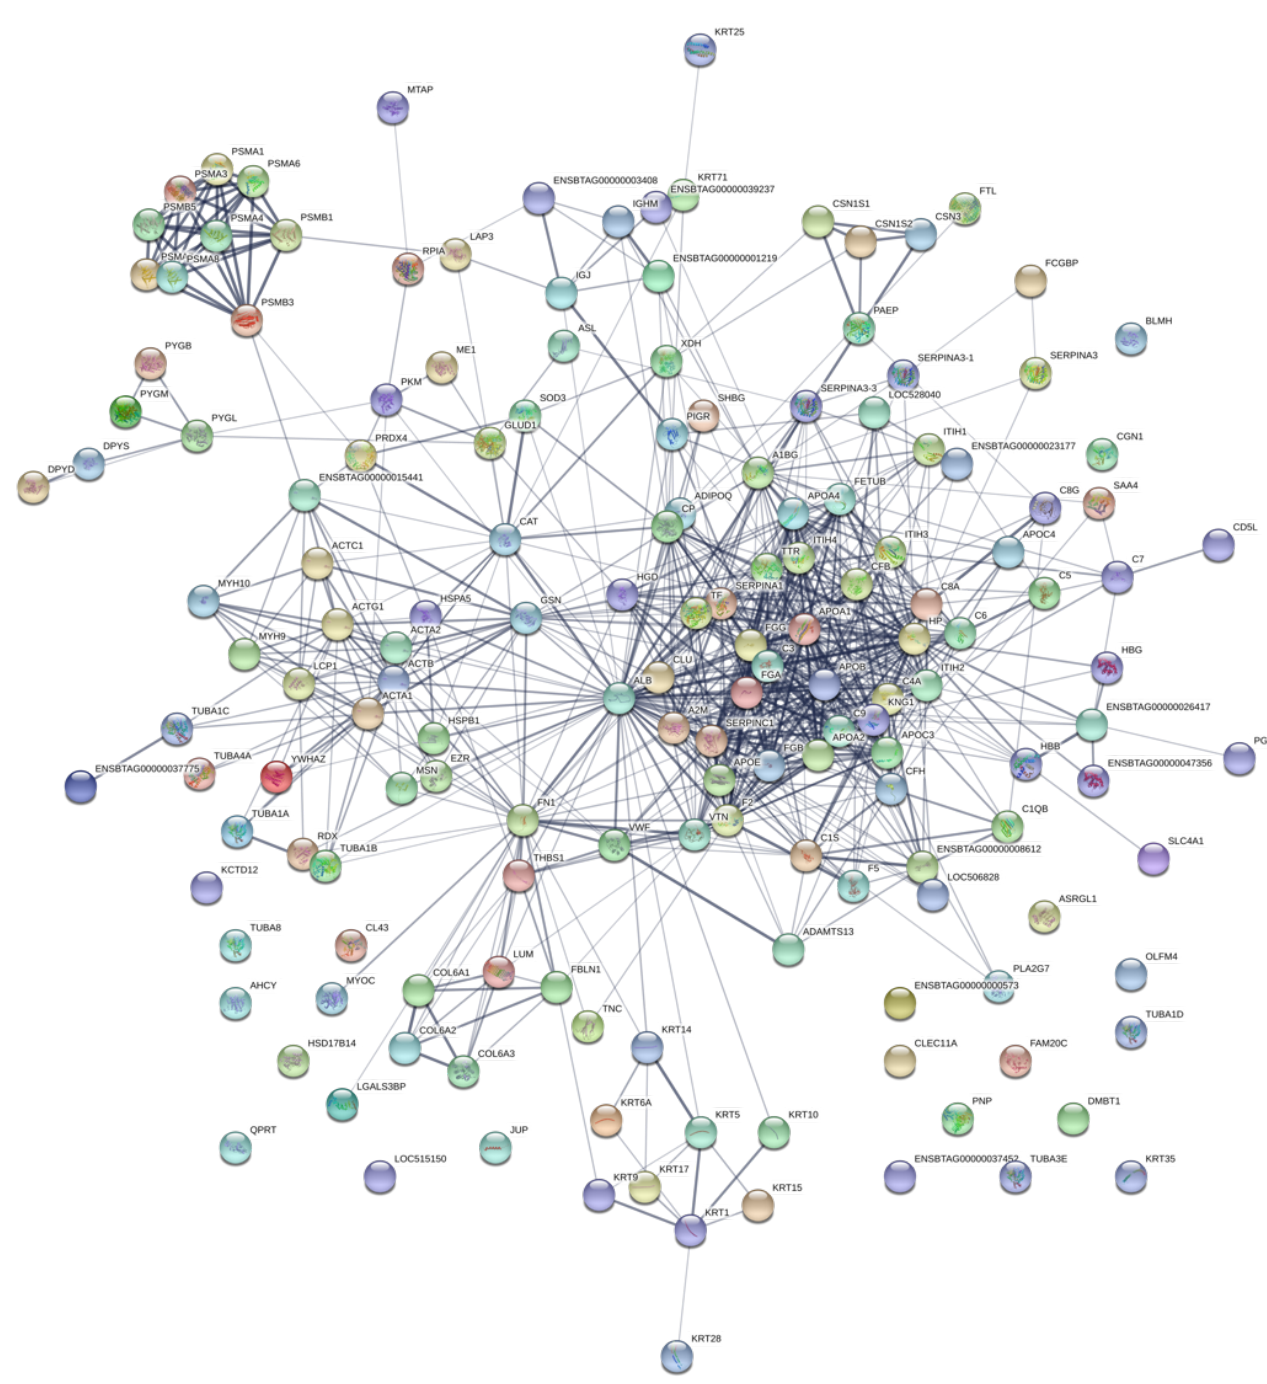
Figure 4. Interaction network among major proteins identified in EV from buffalo serum. The circles represent proteins while the straight lines represent the interactions among different proteins. The stronger associations are represented by thicker